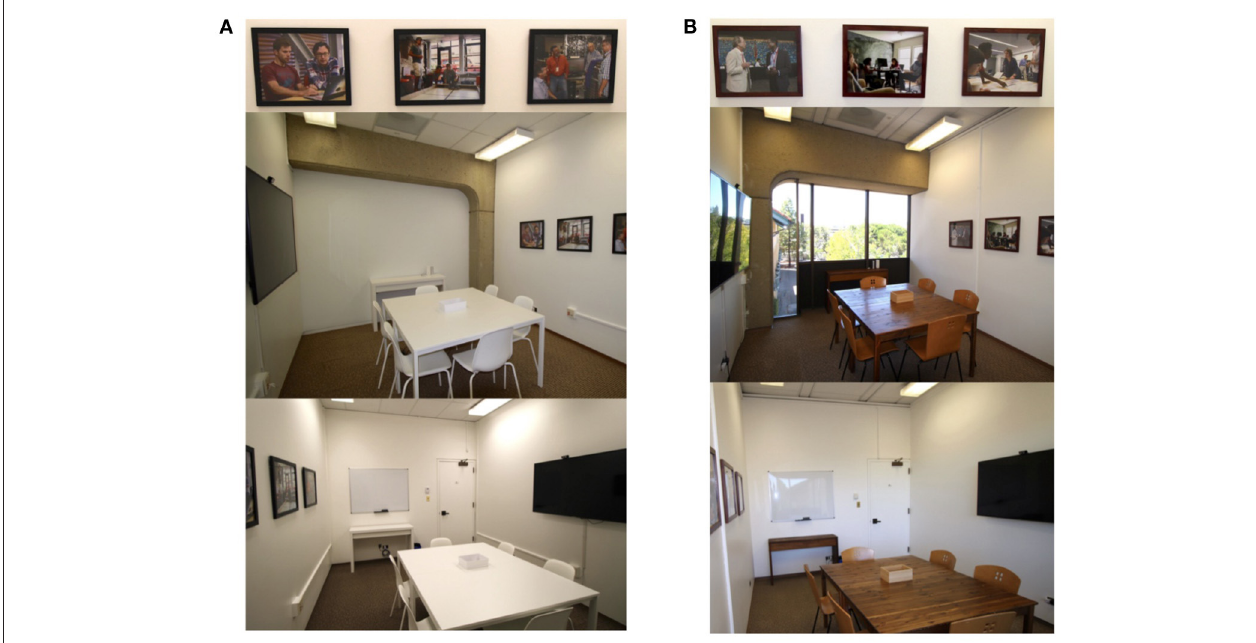
FIGURE 3 | Comparison of participants’ view for two of the eight laboratory room conditions: (A) artificial materials, artificial light and non-diverse representation, and (B) natural materials, natural light and diverse representation.